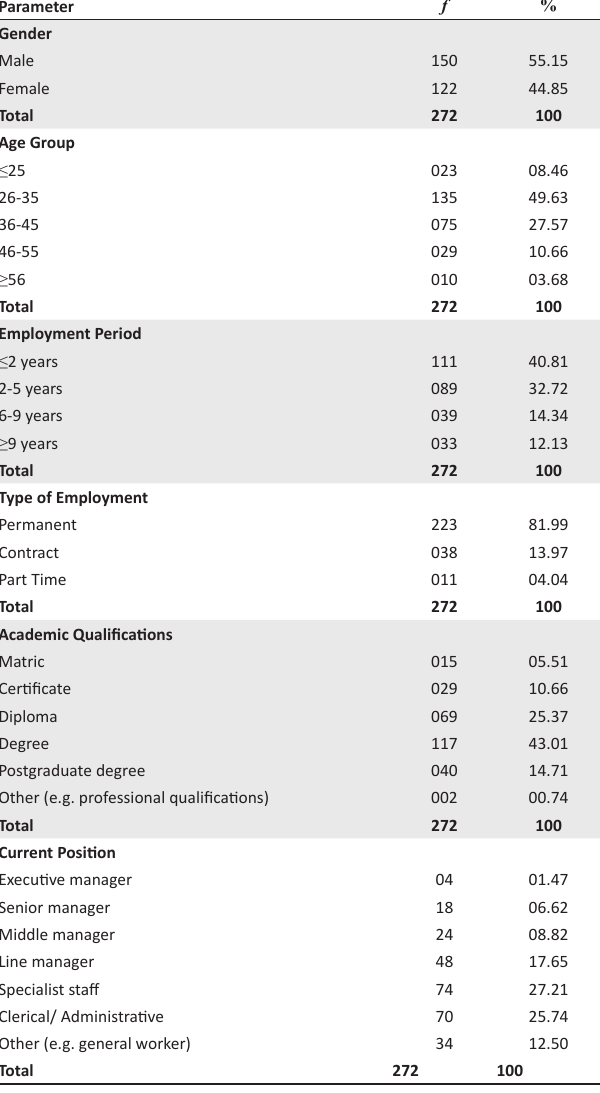
TABLE 1: Sample demographic